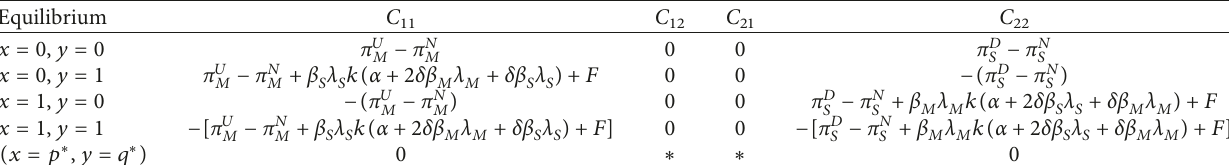
Table 2: The value of C